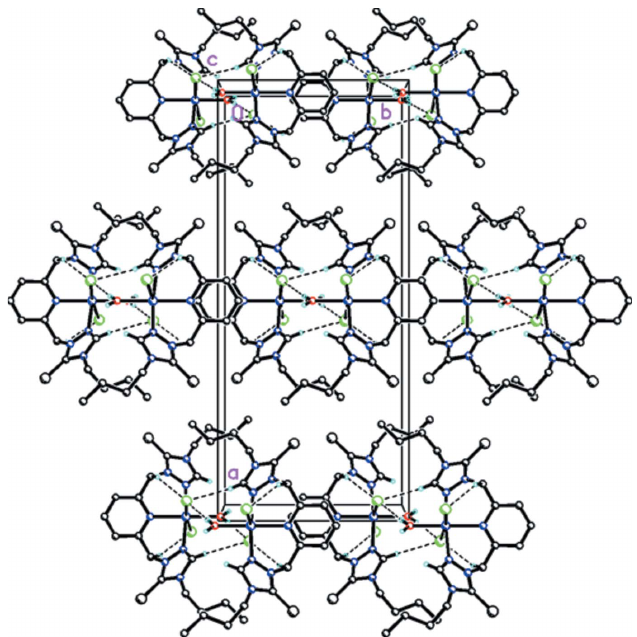
Figure 4 A view of the packing and the unit cell along the c axis for the title complex, 8 . Dashed lines indicate C 2 (6)> a < a infinite chains forming along 2 (001) and R 2 (8)> a > a ring motifs forming a three-dimensional supra- 2 molecular network structure. Stacking of the pyridyl rings face-to-face along the c axis is